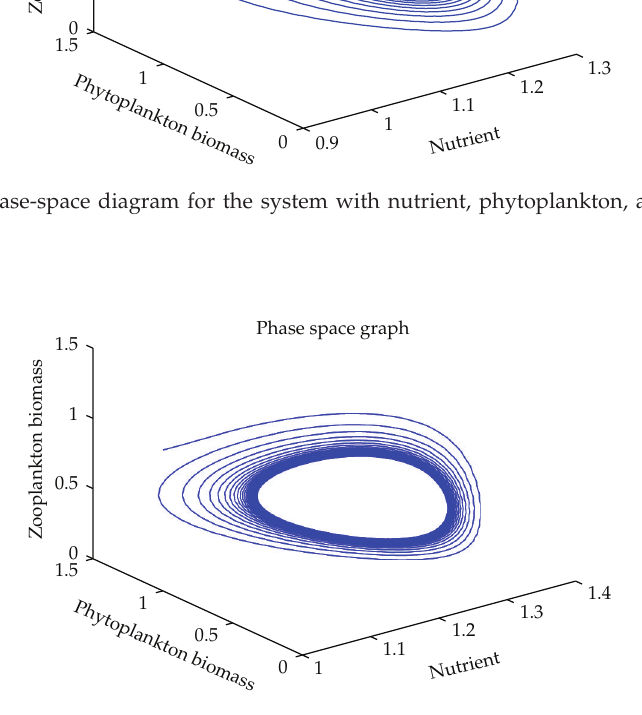
Figure 4: Phase-space diagram for nutrient, phytoplankton, and zooplankton at α (cid:7) 1 . 3.